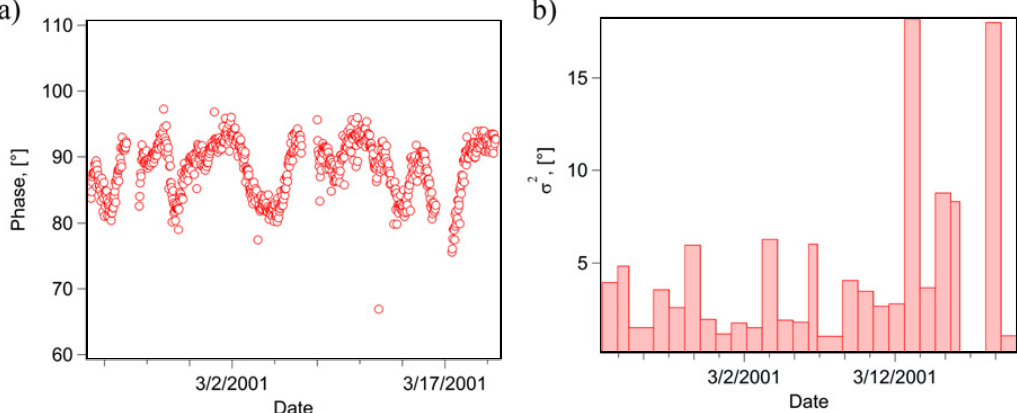
Figure 3. Phase data taken during the deuterium scattering length measurement. (a) Phase data taken over a period of several months. Each point represents the fitted φ from Eq. (5) taken every 21 minutes. (b) The variance defined in Eq. (5) for the data in